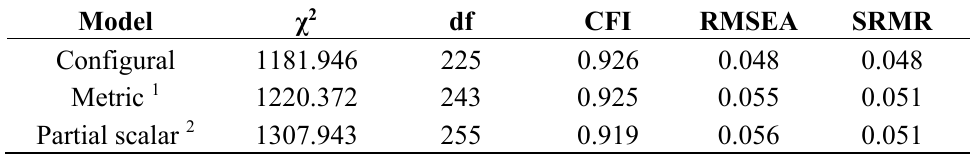
Table 1. Model fit indices for the three levels of measurement invariance ( N =